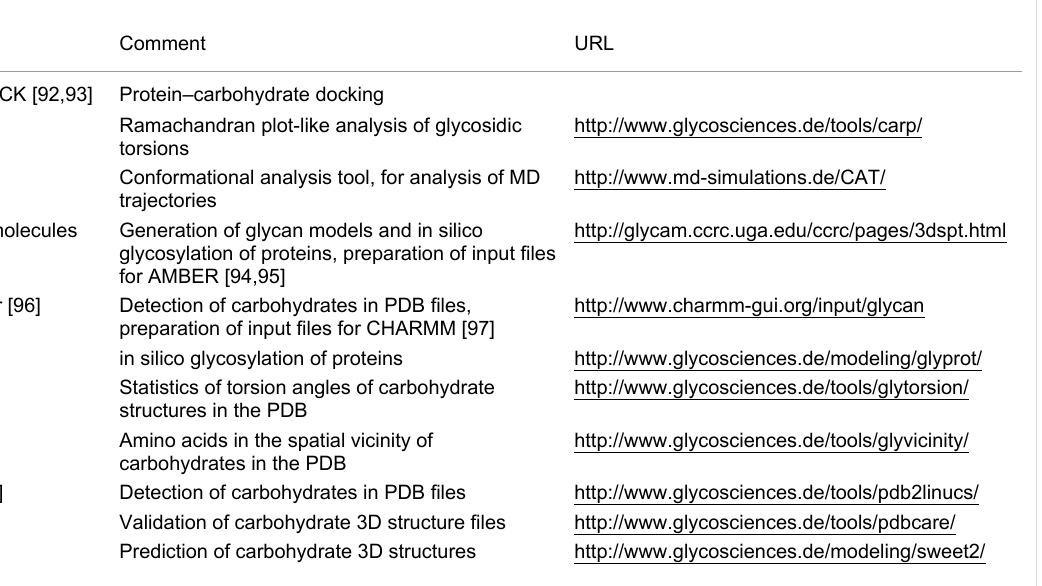
Table 4: Tools for prediction and analysis of carbohydrate/glycoprotein 3D